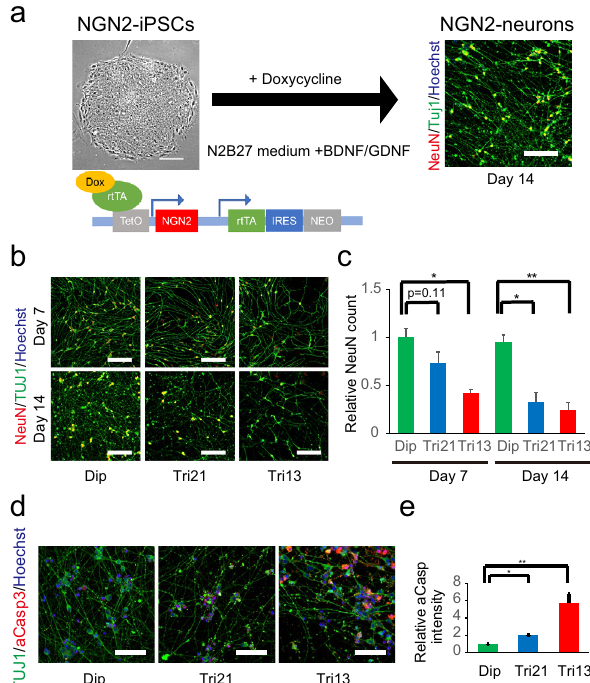
Figure 3. Neurogenesis with Ngn2-inducible iPSCs and decreased cell survival in trisomic neurons. ( a ) NGN2 under the control of the tetracycline operator was introduced into iPSCs using the piggyBac vector. Neurons were generated from iPSCs within 14 days. Representative images of neurons from Dip-NGN2-iPSCs and the construct of the NGN2 inducible piggyBac vector are shown. Scale bar = 200 μm. ( b ) Representative images showing immunocytochemical staining of TUJ1 and NeuN on days 7 and 14 in diploid control and trisomy neurons. Scale bar = 200 μm. ( c ) Quantitative data of the NeuN-positive cells on days 7 and 14. Data are presented as mean ± SEM normalized to the average of diploid clones on day 7. * P < 0.05, n = 4–6 per clone. ( d ) Representative images showing immunocytochemical staining for cleaved caspase 3 (red), TUJ1 (green), and Hoechst 33342 (blue) in NGN2 neurons on day 14. Scale bar = 100 μm. ( e ) Quantification of relative cleaved caspase 3 intensity in NGN2 neurons on day 14. Data are presented as mean ± SEM normalized to the average of diploid clones. * P < 0.05, ** P < 0.001, n = 4 per